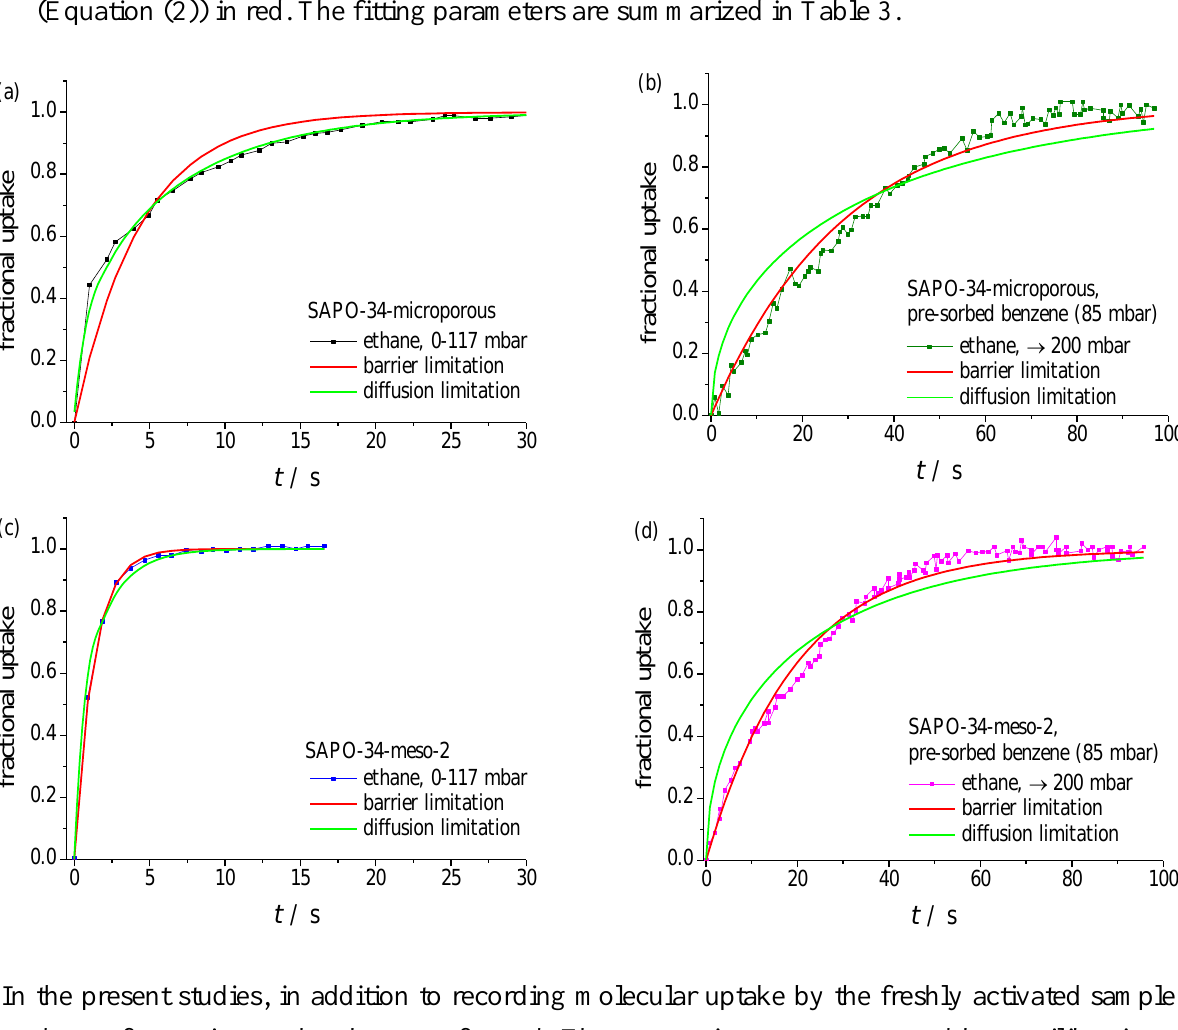
Figure 6. Comparison of the experimentally observed uptake curves (see Figure 5) of ( a , b ) ethane at 298 K in purely microporous SAPO-34; ( c , d ) in SAPO-34-meso-2; following an ethane pressure step from ( a , c ) 0 to 117 mbar; and ( b , d ) after benzene pre-adsorption (equilibration at 85 mbar), with subsequent pressure enhancement to 200 mbar by introducing ethane into the sorption vessel. Uptake curves obtained by fitting for diffusion limitation (Equation (1)) are shown in green and for barrier limitation (Equation (2)) in red. The fitting parameters are summarized in Table